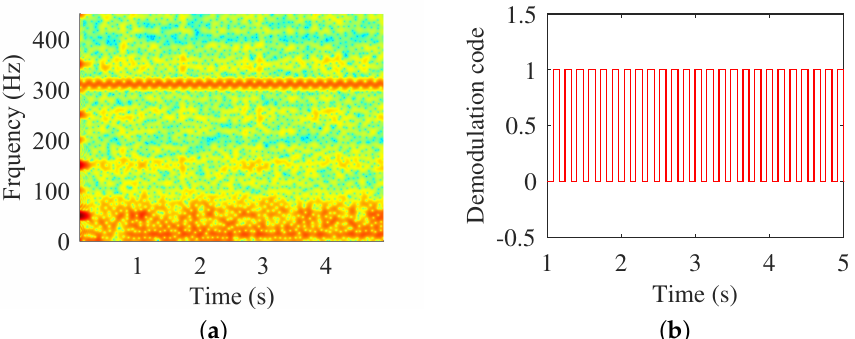
Figure 13. ( a ) Spectrogram of 2FSK signal; ( b ) demodulated code.